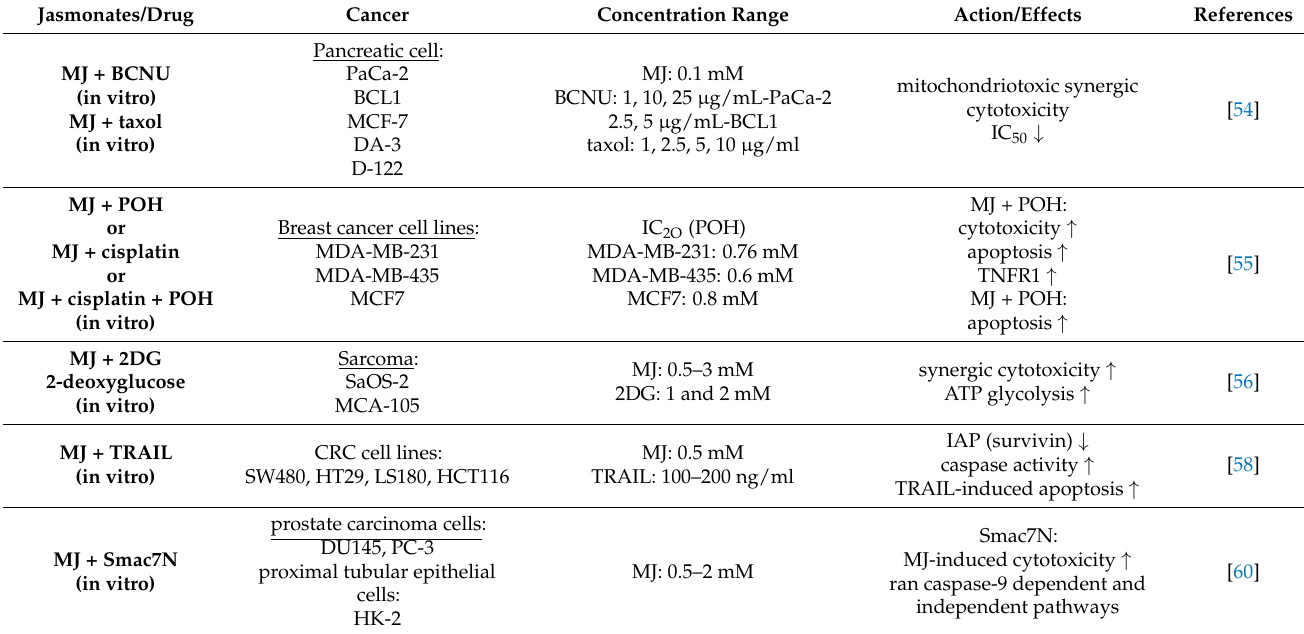
Table 1. Effect of MJ combined with other anticancer